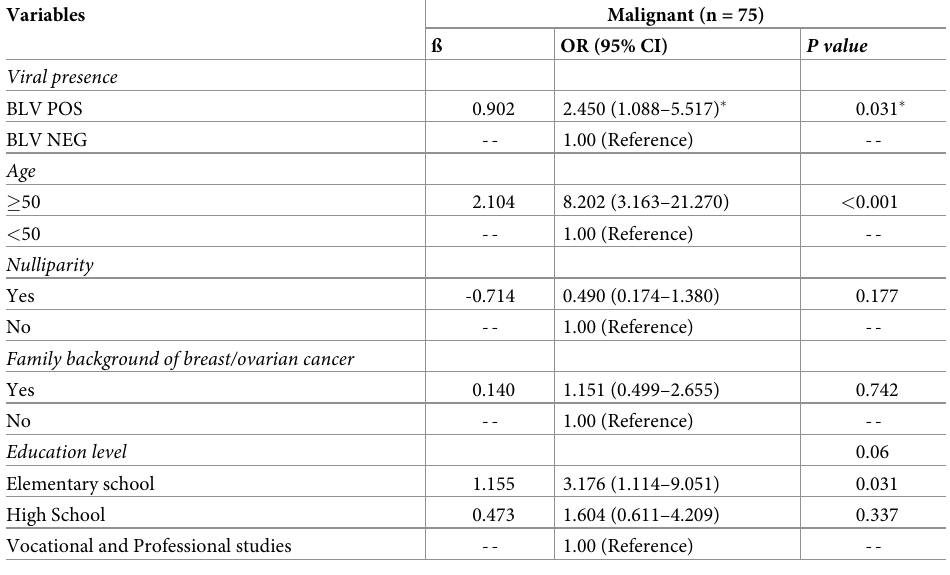
Table 3. Unconditional logistic regression adjusted by risk factors for breast cancer (age, parities, background of cancer in the family and educational level).